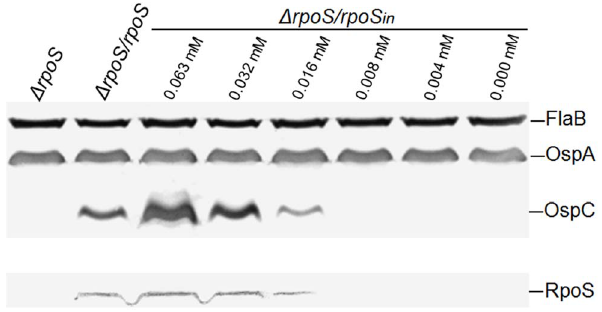
Figure 4. IPTG induces RpoS and OspC expression. A total of six 5.0-ml aliquots of D rpoS/rpoS in spirochetes at a density of 10 4